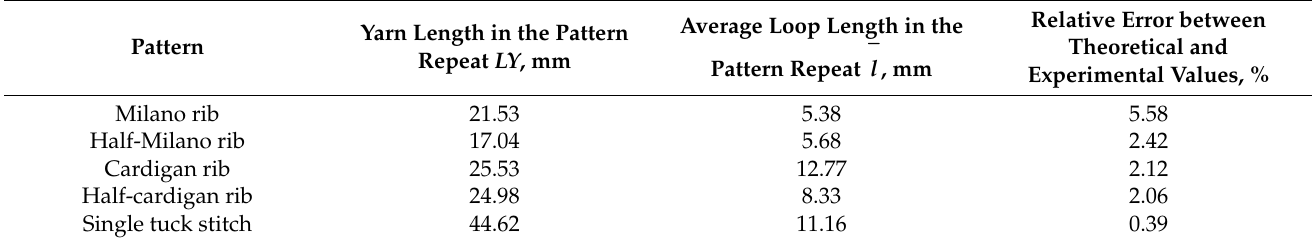
Table 4. Theoretically calculated yarn length in pattern repeats, average loop length, and relative error between the theoretically calculated and experimentally measured